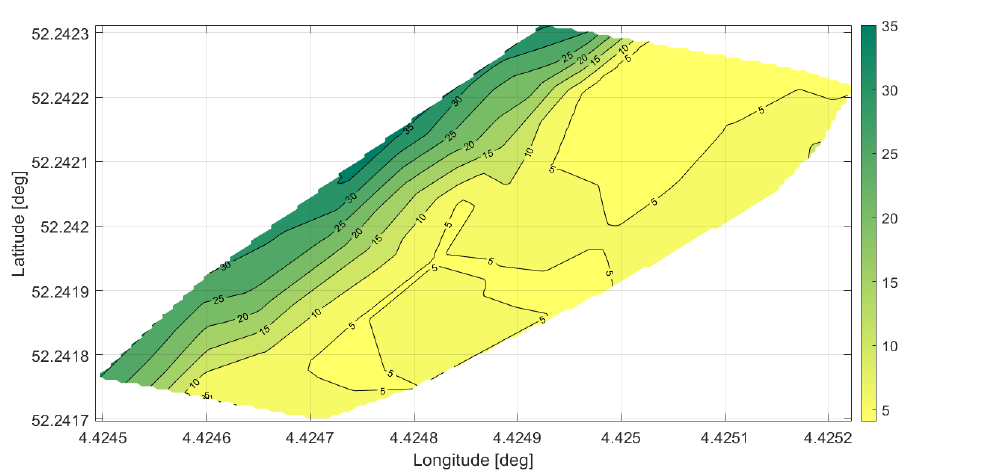
Figure 10. Contour map of the surface moisture in the study area during the in situ measurements collected on 30 January 2020 at the same time that Sentinel-1 passed over Noordwijk (7:08